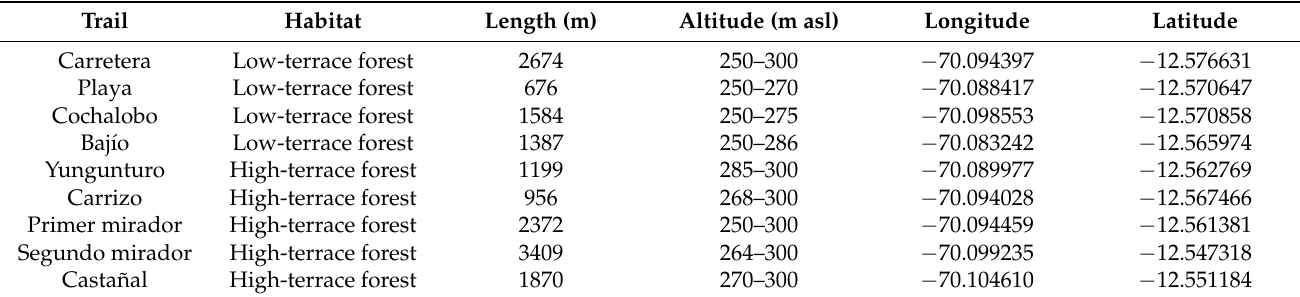
Table 1. Geographical characterization of the trails evaluated in the study.